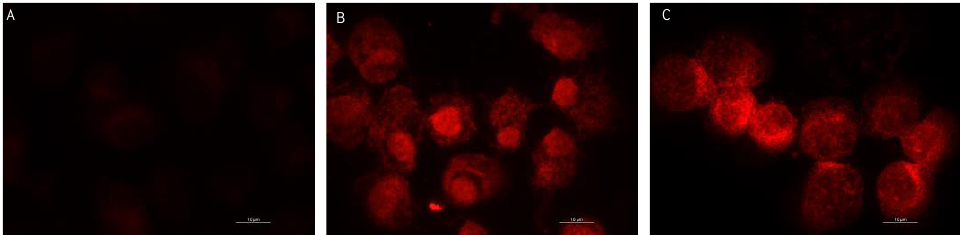
Figure 8. Untreated T-24 cells ( A ), cells treated for 7h with Nile Red loaded niosomes ( B ) and Nile Red and CIP co-loaded niosomes ( C ).